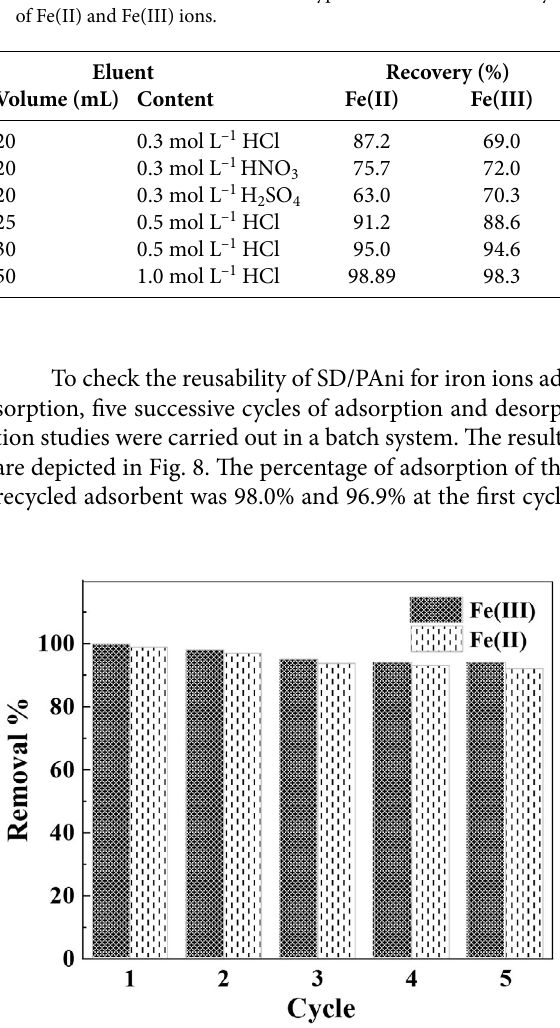
Figure 8. Effect of cycle times on the removal efficiencies of iron Table 3. Comparison of the characteristics of the proposed method with the previously published methods. Adsorbent